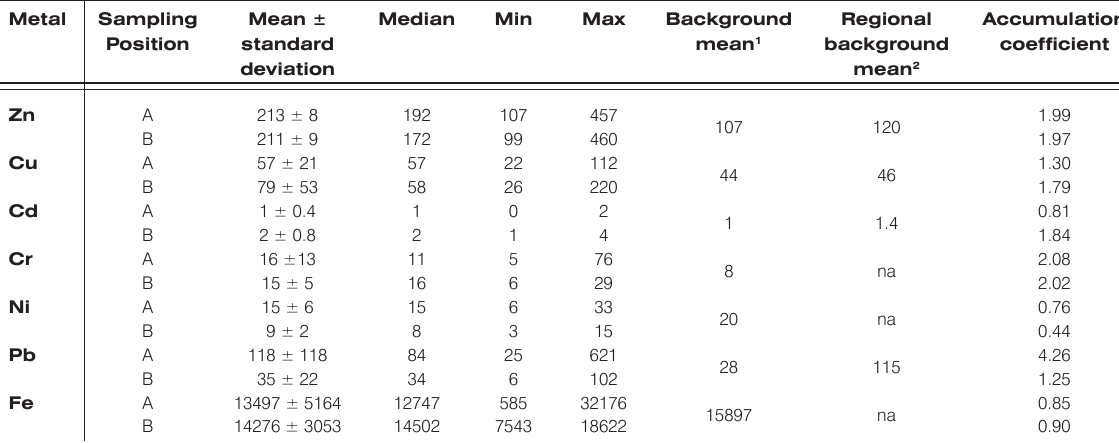
Table 1. Concentrations of metals (mg kg -1 ) near curb (A) and 1 m from the curb (B) as measured between 06/03/10 and